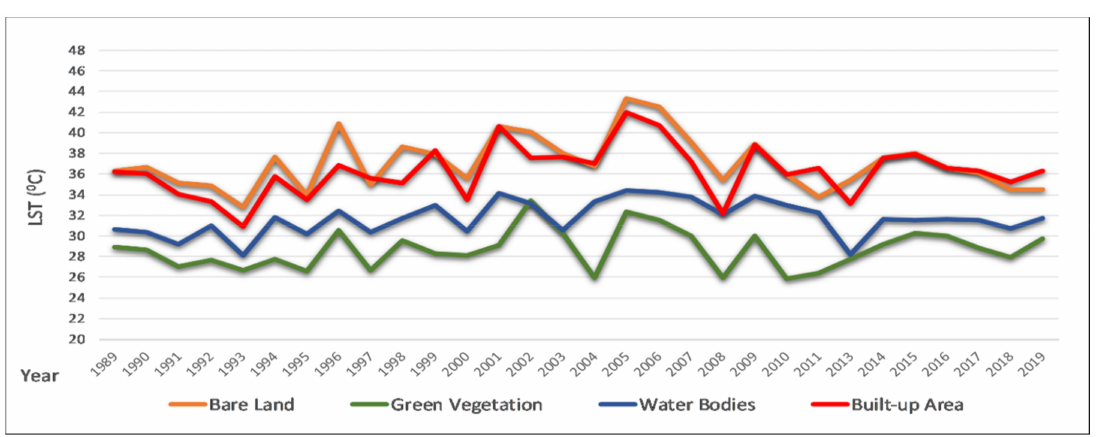
Figure 6. The mean LST ( ◦ C) by land-cover type from 1989 to 2019.